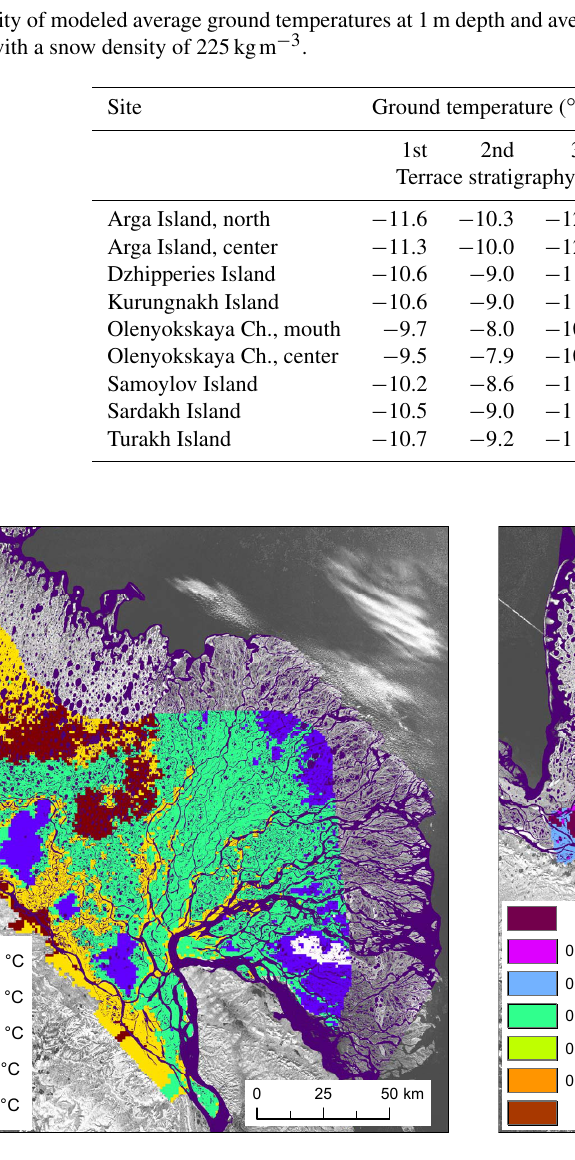
Figure 13. Modeled average maximum thaw depths for the period 2004–2013, with a snow density of 225kgm − 3